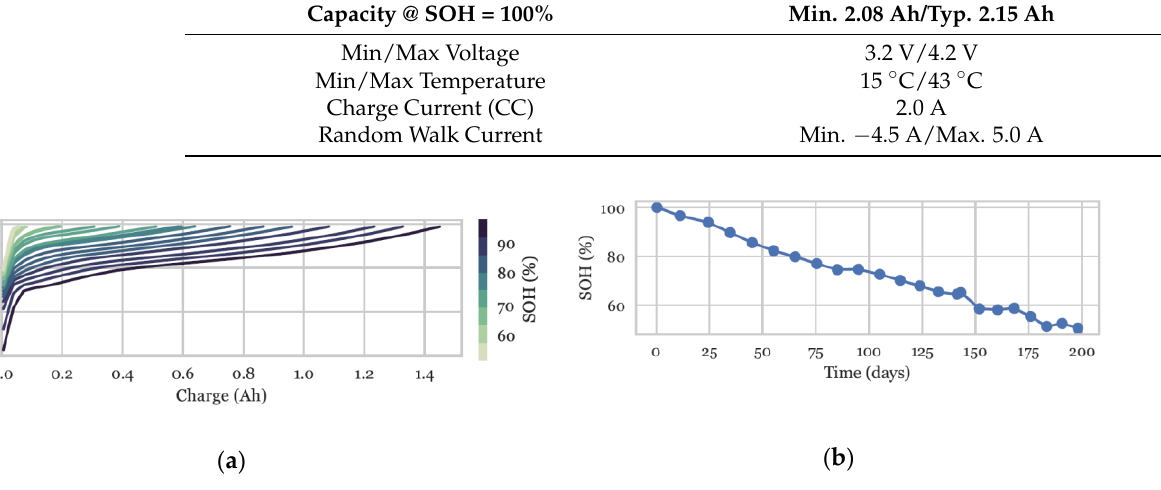
Figure 2. ( a ) CC segment of charge profile of a Li-ion cell throughout randomized usage aging process; color spectrum of profiles indicate SOH. ( b ) Recorded capacity-based SOH for each of the charge profiles in ( a ).